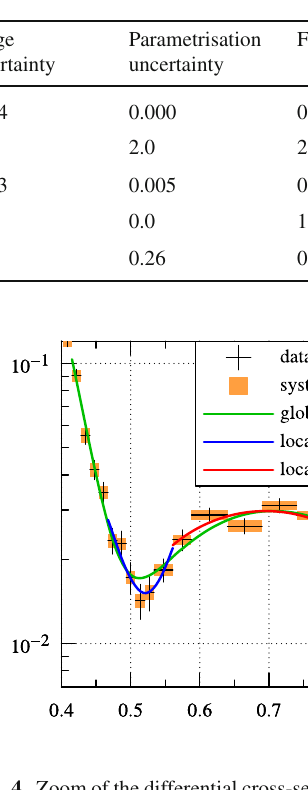
Fig. 3 Differential cross-section from Table 1 Fig. 4 Zoom of the differential cross-section (black points) in the dip-